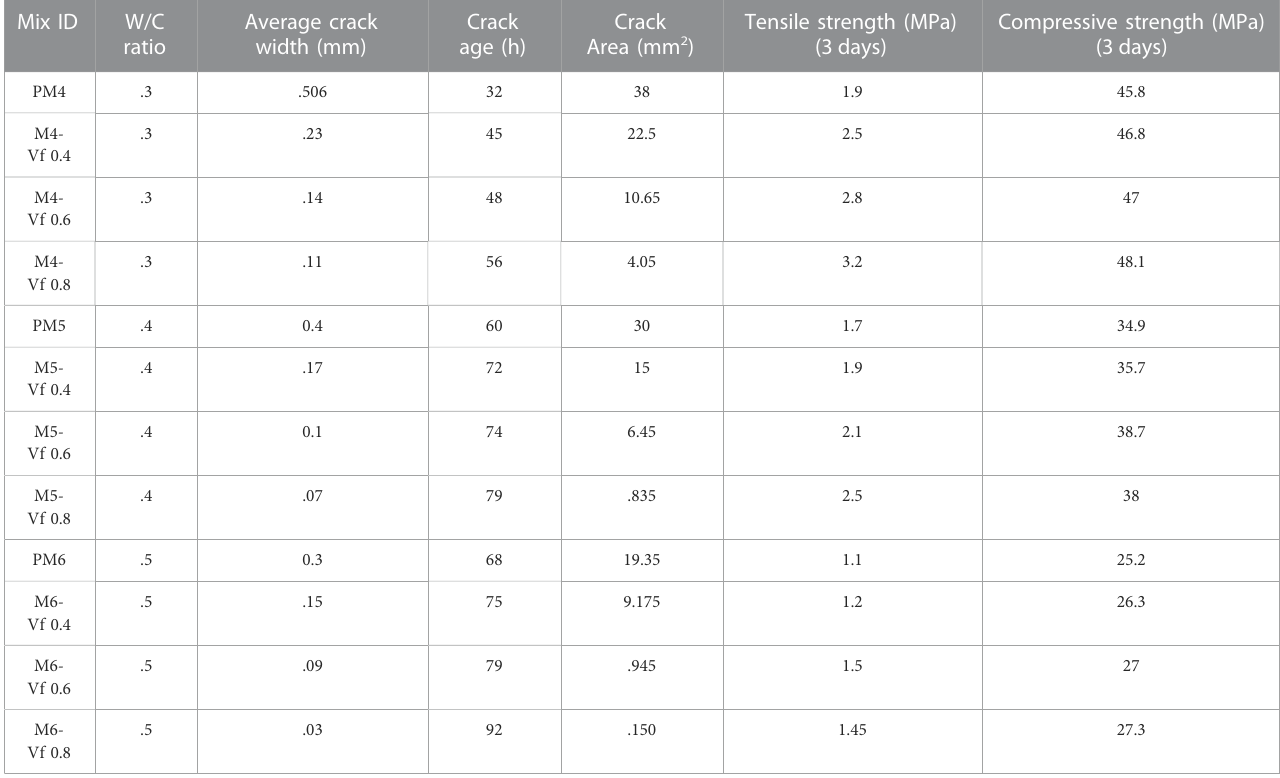
TABLE 7 Crack characteristics and mechanical properties with different fi bre fractions for cement-paste